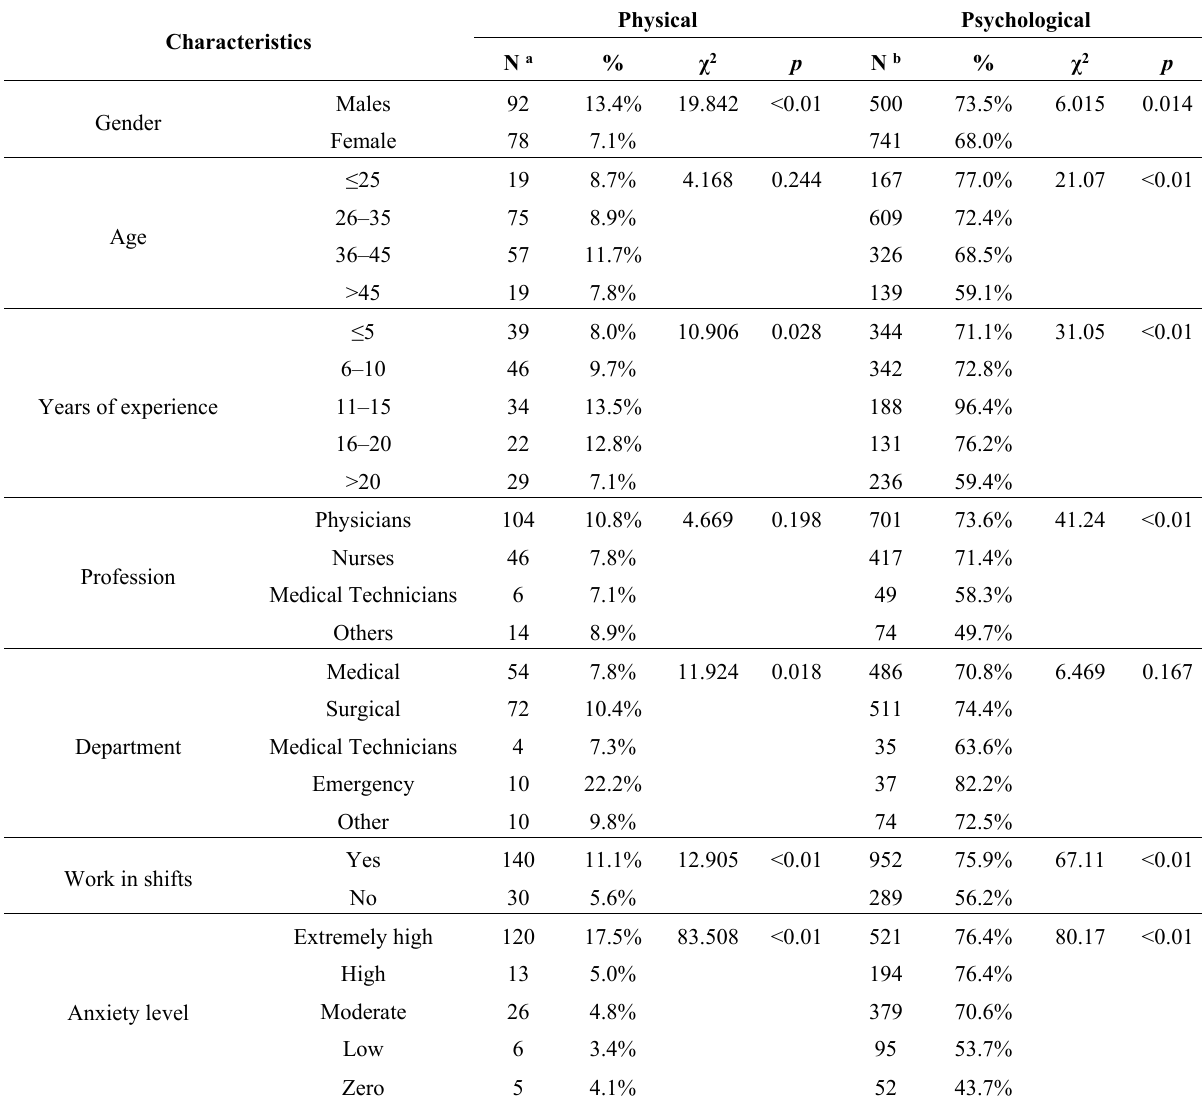
Table 1. Frequency distributions of the characteristics of the workers exposed to physical and psychological